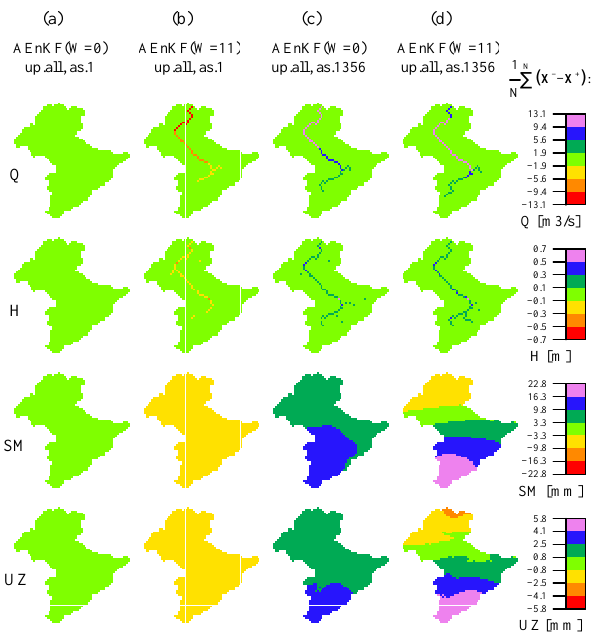
Figure 5. Mean difference between the forecasted ( X − ) and up- dated ( X + ) model states on 31 December 2002 at 00:00UTC for different scenarios (shown in vertical panels). We show only four sensitive model states: discharge ( Q ), water level ( H ), soil mois- ture (SM) and upper zone (UZ). We excluded the insensitive lower zone (LZ). Notations W = 0 and W = 11 indicate the size of the state augmentation. Notation up.all indicates that all of the model states are updated. Notation as “xx” indicates the gauges which are assimilated; see Fig. 2 for their locations. The corresponding en- semble of model forecasts and observations being assimilated are shown in Fig.